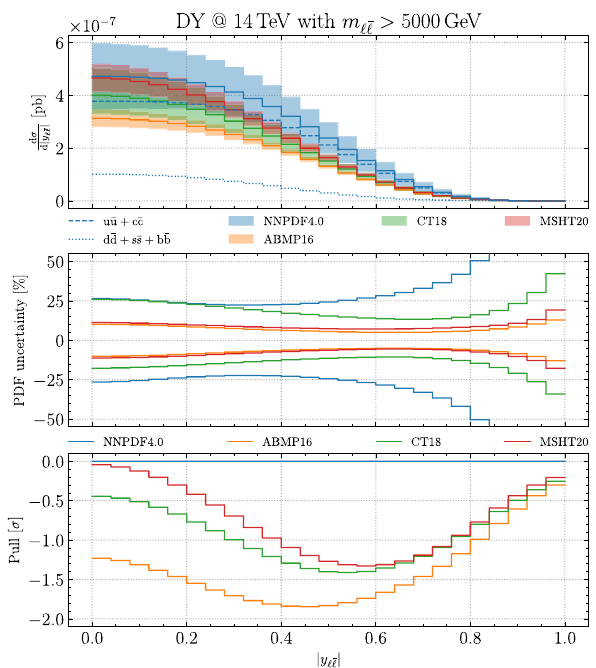
Fig. 17 The differential distribution in absolute dilepton rapidity | y (cid:2) ¯ (cid:2) | , given in Eq. (2.21), for dilepton invariant masses of m (cid:2) ¯ (cid:2) > 5 TeV for neutral current Drell–Yan production at the LHC 14 TeV, obtained using ABMP16, CT18, MSHT20, and NNPDF4.0 NNLO PDFs with α ( m ) = 0 . 118. All uncertainties shown are 68% CL PDF uncertain- s Z ties, computed at NLO QCD with realistic cuts (see text). We show the absolute distributions (top), relative uncertainties (normalized to the central curve of each set, middle) and the pull with respect to the NNPDF4.0result,Eq.(4.2)(bottom).ForthecentralNNPDF4.0predic- tionthecontributionsofthe u ¯ u + c ¯ c and d ¯ d + s ¯ s + b ¯ b partonsubchannels are also